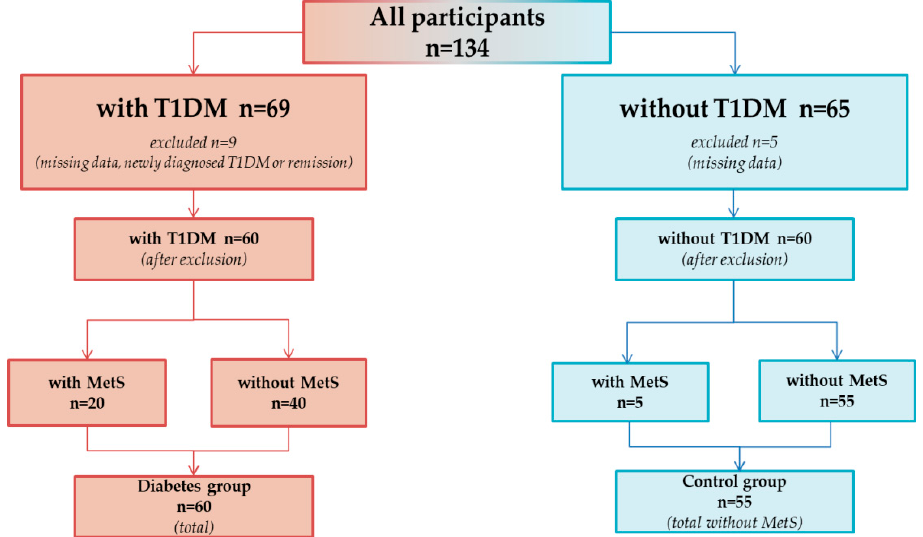
Figure 1. Flowchart of the inclusion process in the study.